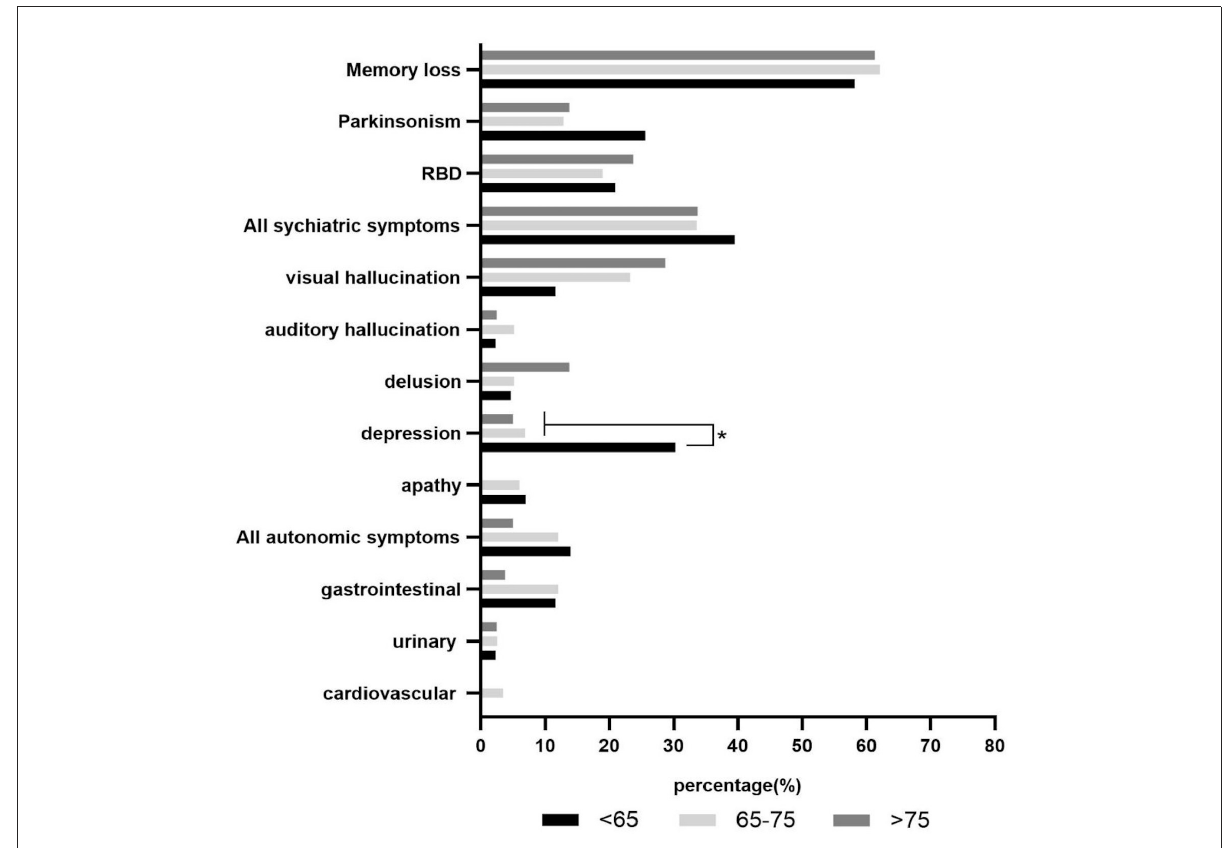
FIGURE2 Correlation between age and initial symptoms of patients with DLB. * The results showed significant difference between middle-aged and elder patients. * p < 0.001.